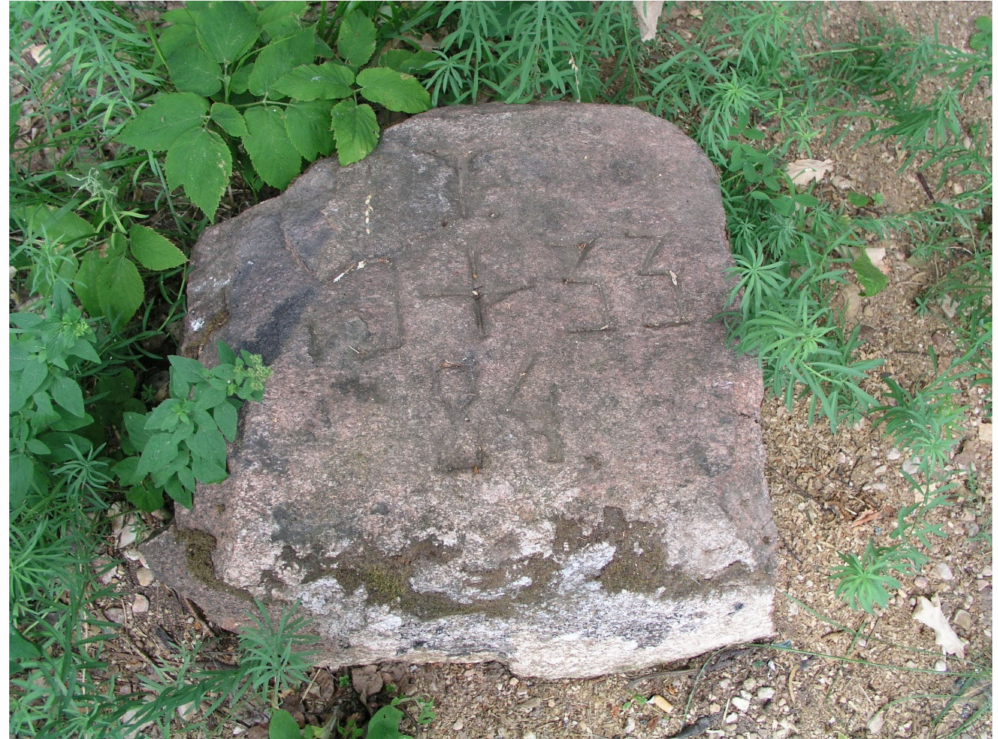
Figure 2. A bordermark in Tsirgumäe village, Valga municipality, Valga county (photo: Anu Prints- mann